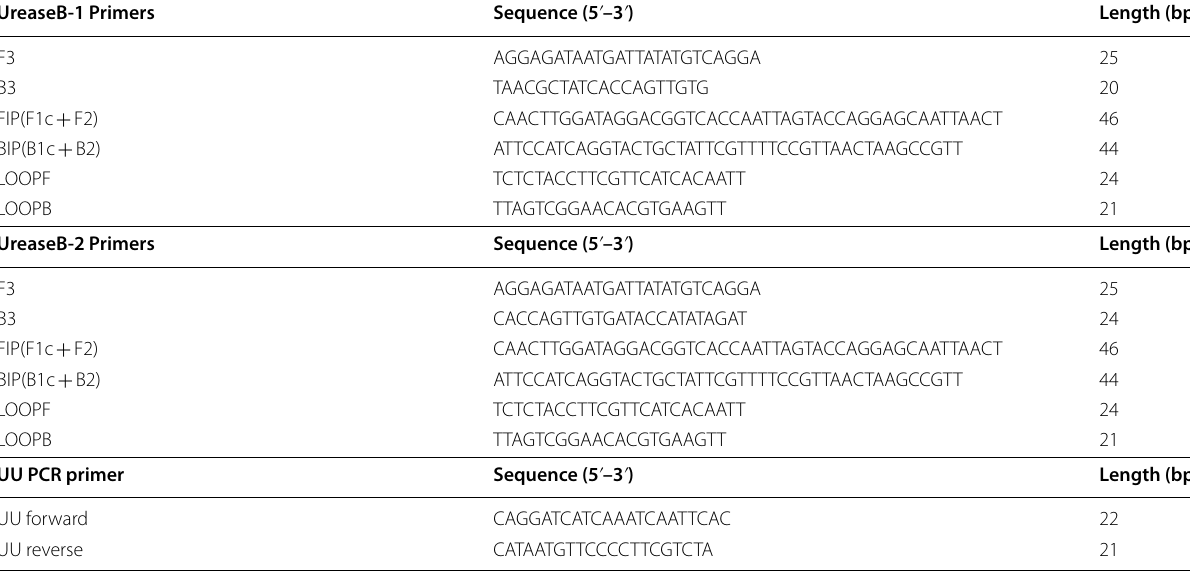
Table 2 Primers used for the real‑time fluorescence LAMP and PCR reaction system UreaseB‑1 Primers